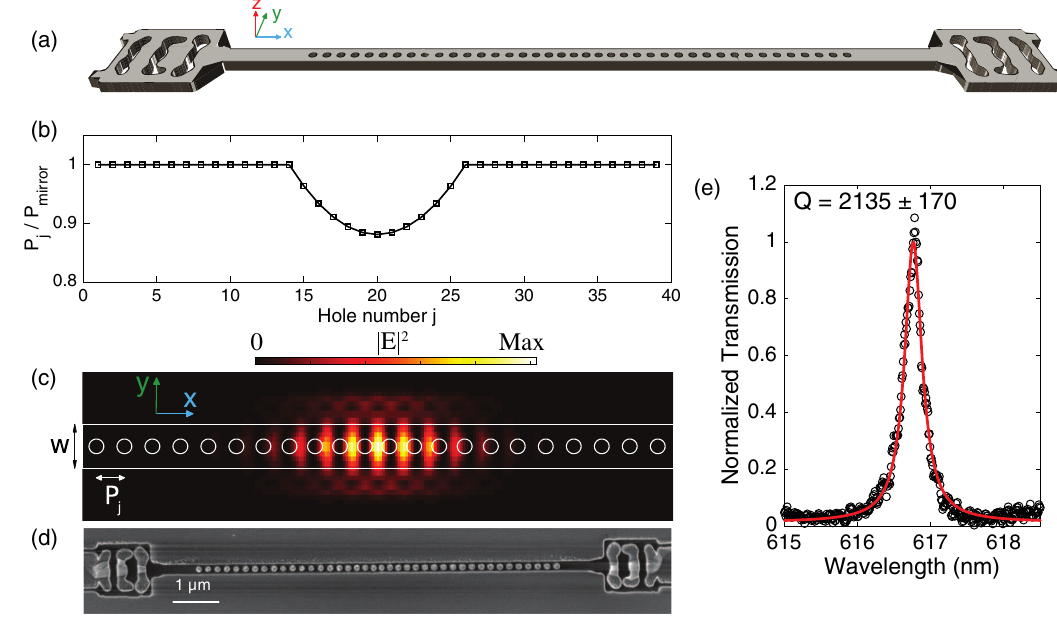
FIG. 1. Design and simulation of the nanobeam photonic crystal cavity. (a) Schematic of the proposed one-dimensional photonic crystal cavity. Two inverse-designed vertical couplers on either end of the beam enable the coupling of light into and out of the device. (b) Spacing between the holes for different hole numbers. A quadratic taper over the center 12 holes creates the cavity. (c) Finite- difference time-domain simulation of electric field magnitude squared j E j 2 showing confinement of light in the center of the cavity. (d) Scanning electron microscope image of a fabricated device. (e) Spectrum of a cavity mode of a representative device obtained from a transmission measurement through the device. The quality factor of this device is Q ¼ 2135 (cid:2) 170